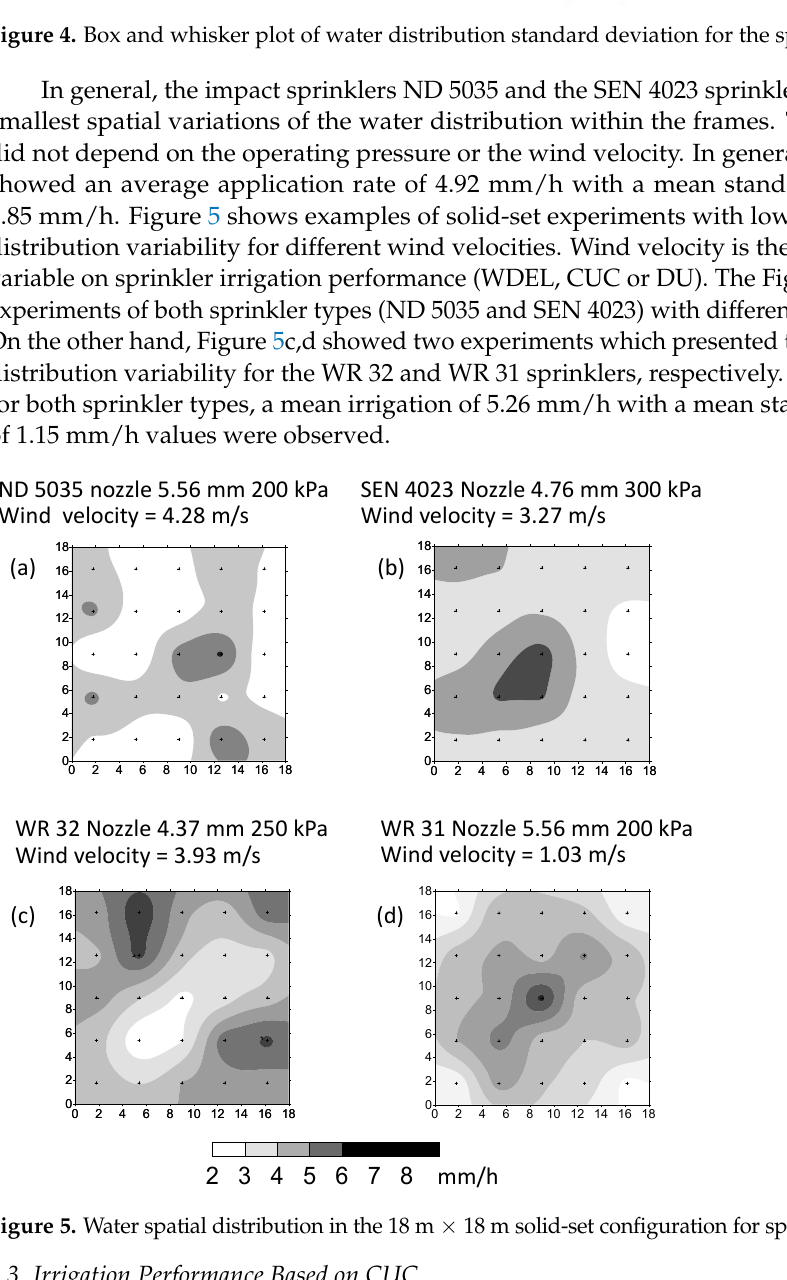
Figure 4. Box and whisker plot of water distribution standard deviation for the sprinkler analyzed.